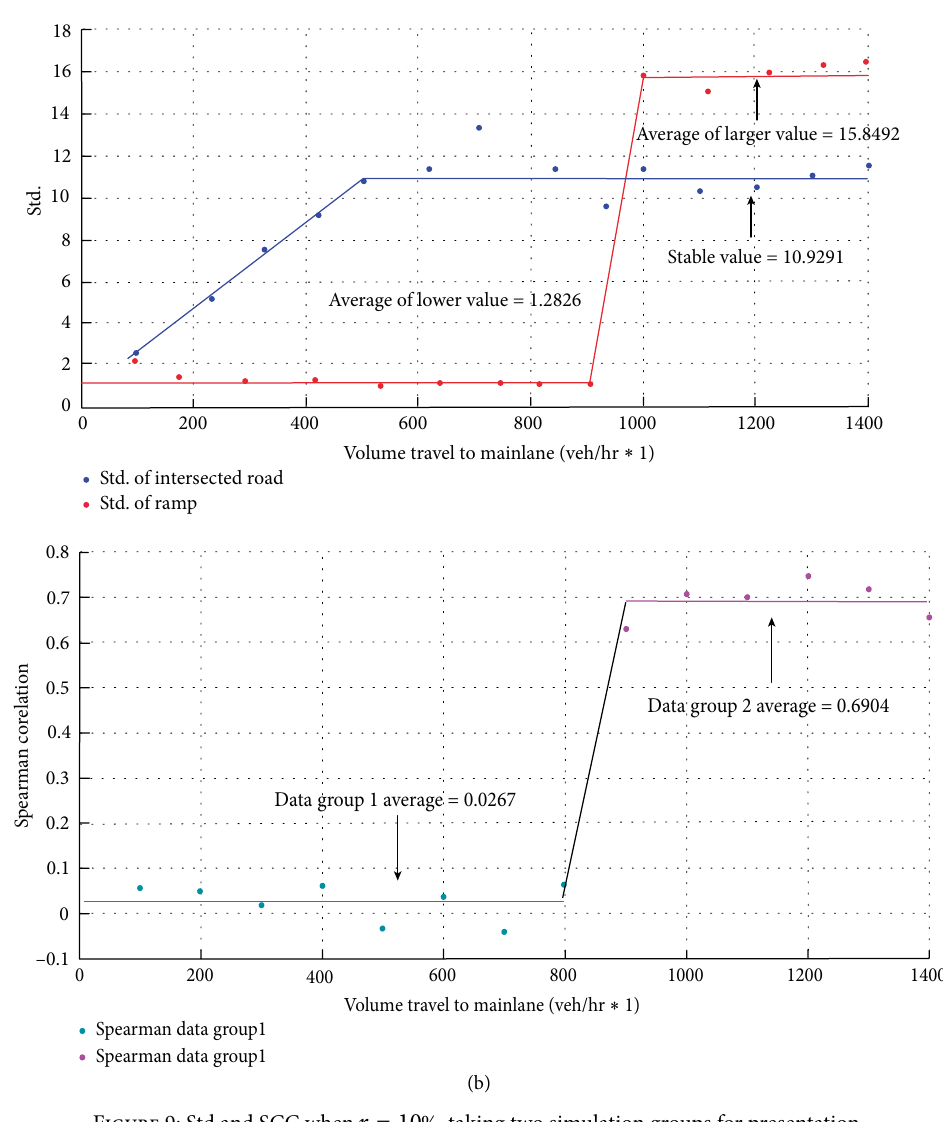
Figure 9: Std and SCC when 𝑟 = 10 %, taking two simulation groups for